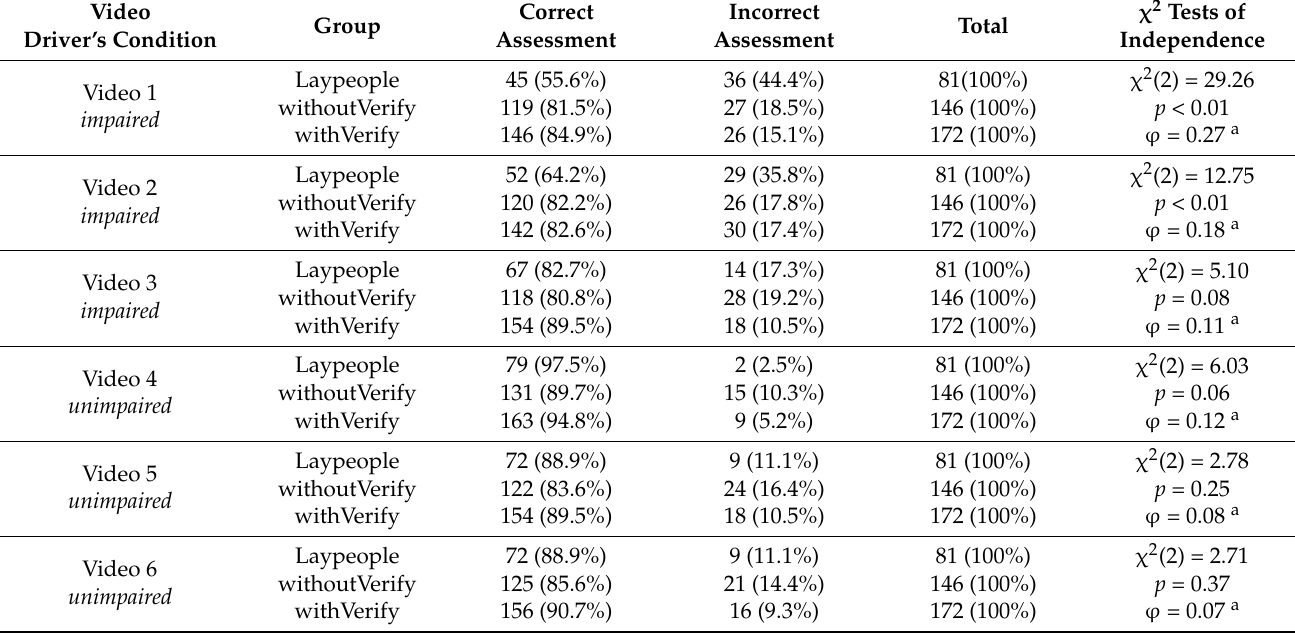
Table 5. Frequency analyses and χ 2 tests for rating in driving